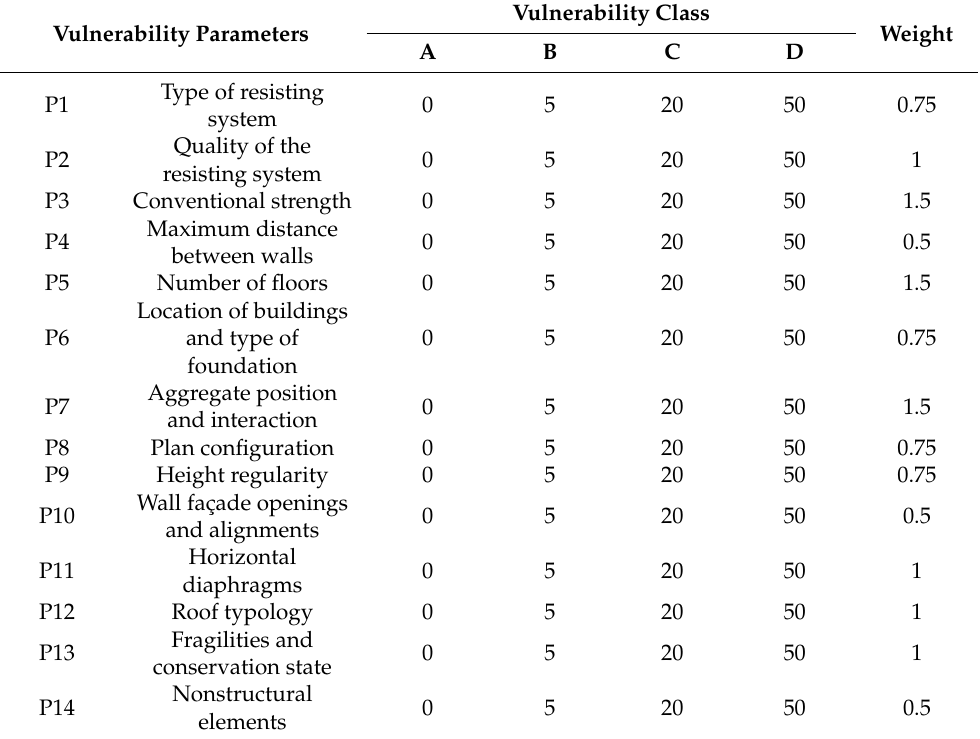
Table 1. Parameters adopted in the Vicente methodology, vulnerability classes and associated weights.